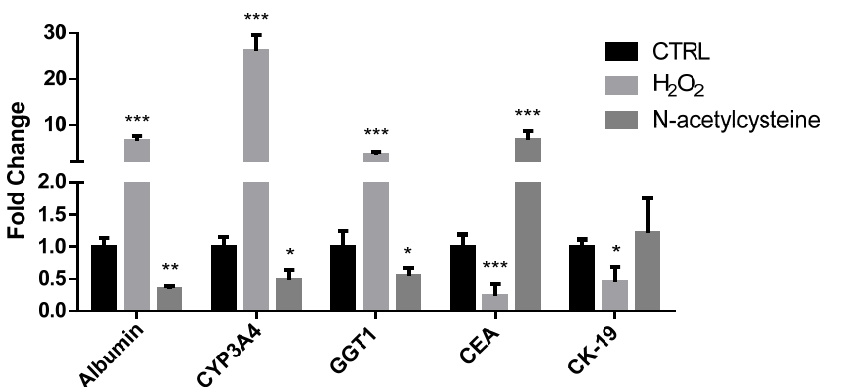
Figure 4. mRNA expression of genes associated with differentiation status in confluent HepaRG cells exposed to vehicle (CTRL), 100 µ M H 2 O 2 , or 1 mM N-acetylcysteine every 24 h for 5 days. In the bar graph, data are illustrated as mean ± SEM of three replicates. Statistical differences were analyzed by one-way ANOVA; Tukey–Kramer was used as post hoc test. * = p < 0.05 vs. CTRL; ** = p < 0.01 vs. CTRL; *** = p < 0.001 vs. CTRL.